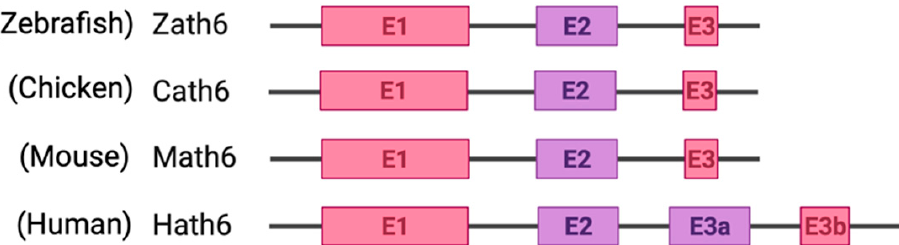
Figure 2. Schematic representation of exons and introns of Atoh8 in different orthologues. Zebrafish atonal homolog 6 (Zath6); Chicken atonal homolog 6 (Cath6); Mouse atonal homolog (Math6); Hu- man atonal homolog 6 (Hath6). Concerning regulatory aspects of Atoh8, the comparison of sequences upstream to Atoh8 in zebrafish, chicken, mice and humans revealed that the Atoh8 promoter has evolved from a ‘TATA box’ with a single transcriptional initiation site to the much more